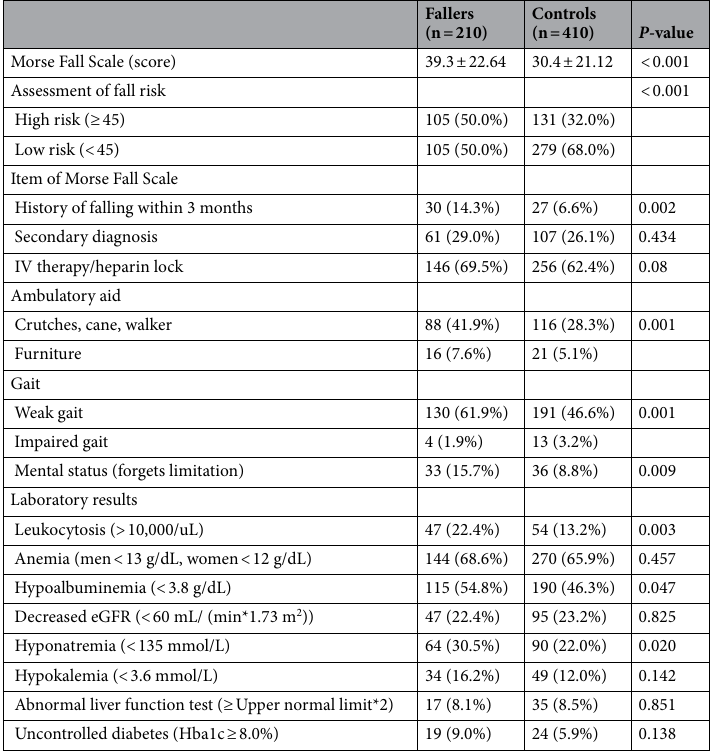
Table 2. Fall risk assessment and laboratory results of fallers and matched controls. Data are presented as means (standard deviation) or frequencies (percentage), as